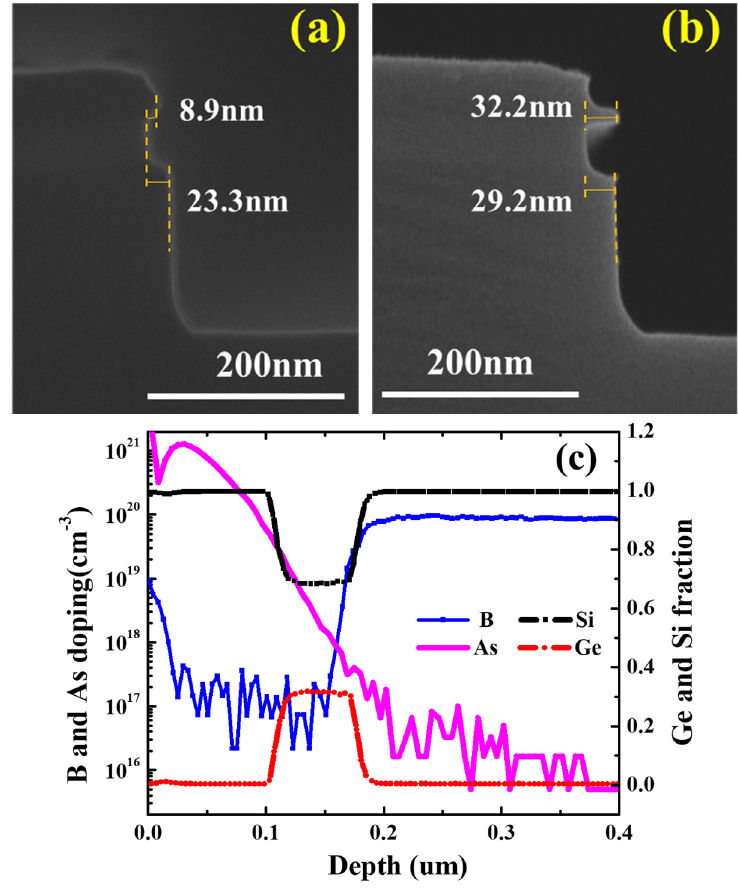
Figure 4. The SEM cross-section images of Sample III after digital etching at 50 cycles with ( a ) 30% H 2 O 2 -dBOE q-ALE and ( b ) 31.5% HNO 3 -dBOE q-ALE. ( c ) SIMS data of boron/arsenic and the Ge/Si mole fraction in Sample III. An abrupt B profile was formed by in situ doped epi, as the profile exhibits a large diffusion into SiGe.